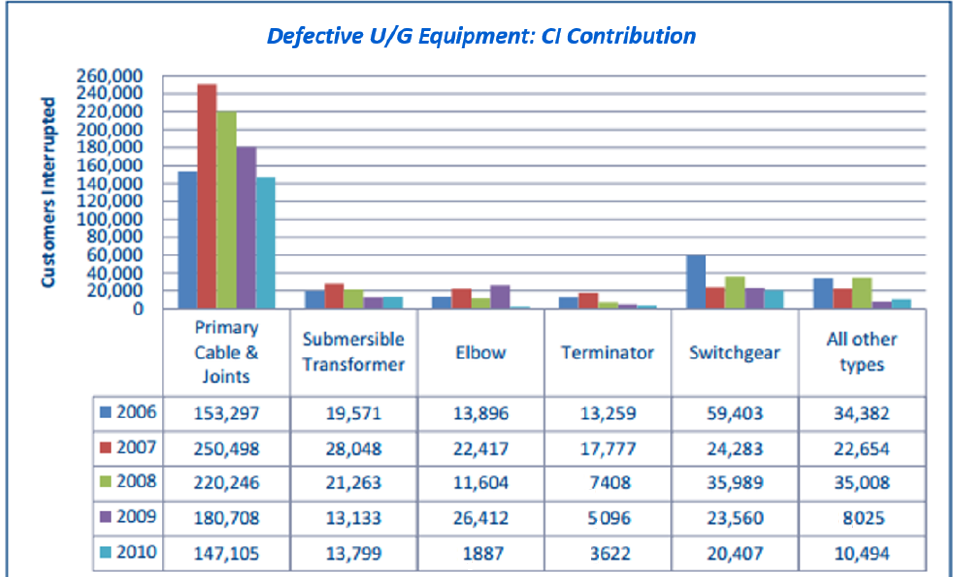
Figure 1. Significant customer interruptions for UG primary cables and joints observed for a Canadian power distribution utility firm without proactive maintenance.